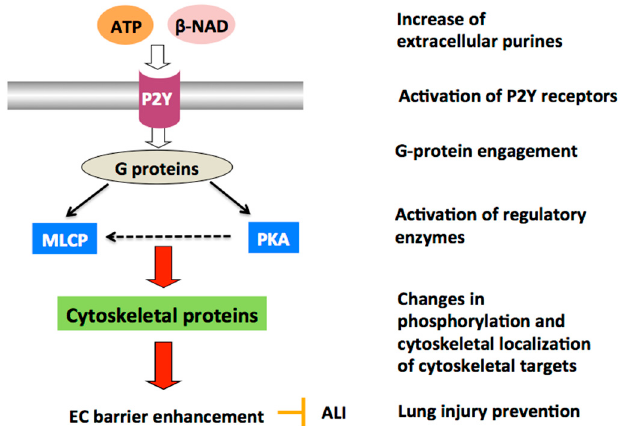
Figure 2. P2Y-mediated mechanisms of lung endothelial barrier protection. P2Y agonists (ATP, ATP γ S, or β -NAD) enhance endothelial barrier properties via consequential activation of heterotrimeric G-proteins and enzymes, like myosin light chain phosphatase (MLCP) and PKA, followed by cytoskeletal rearrangement, increased cell-cell contacts, and tightening of endothelial cell (EC) barrier, thus opposing acute lung injury progression.